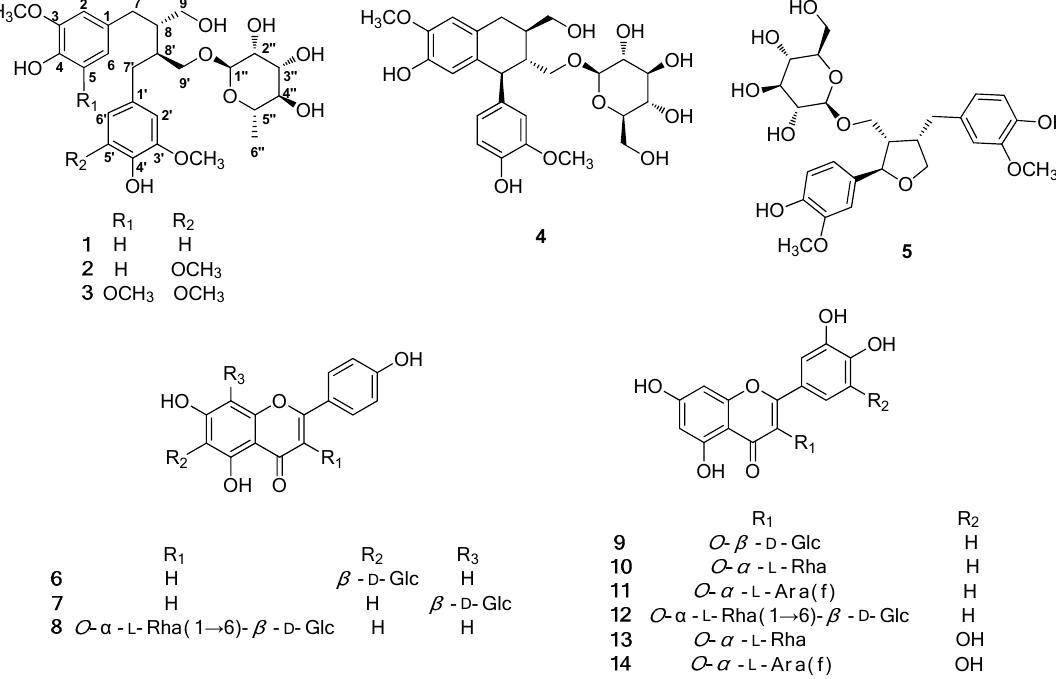
Figure 1. Chemical structures of compounds 1 – 14 . Glc, glucopyranosyl; Rha, rhamnopyranosyl; Ara(f), arabinofuranosyl.